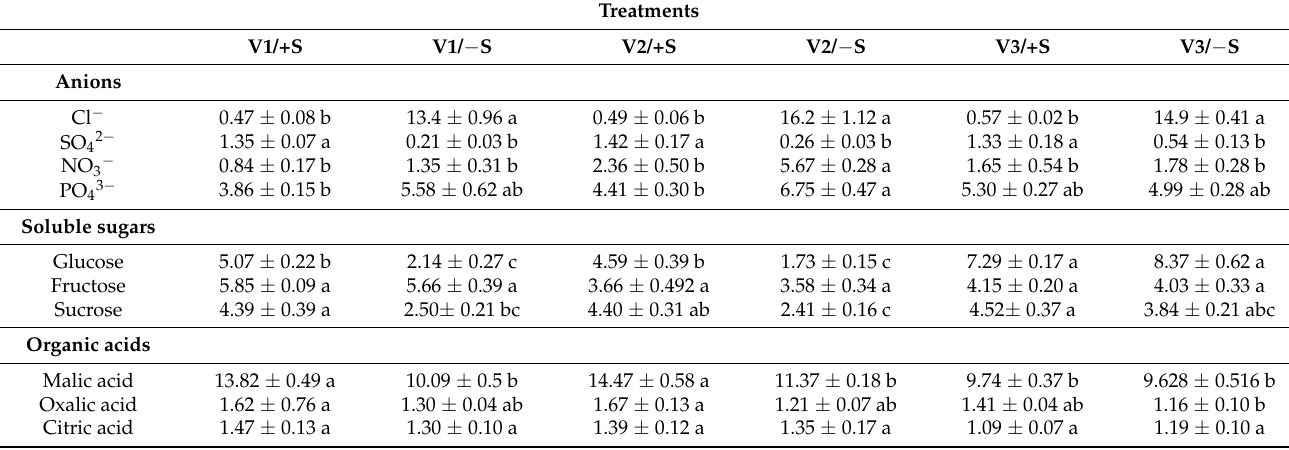
Data presented are the means ± SDs of four replicates. Different letters show statistically significant differences among all the treatments ( p ≤ 0.05; Tukey’s